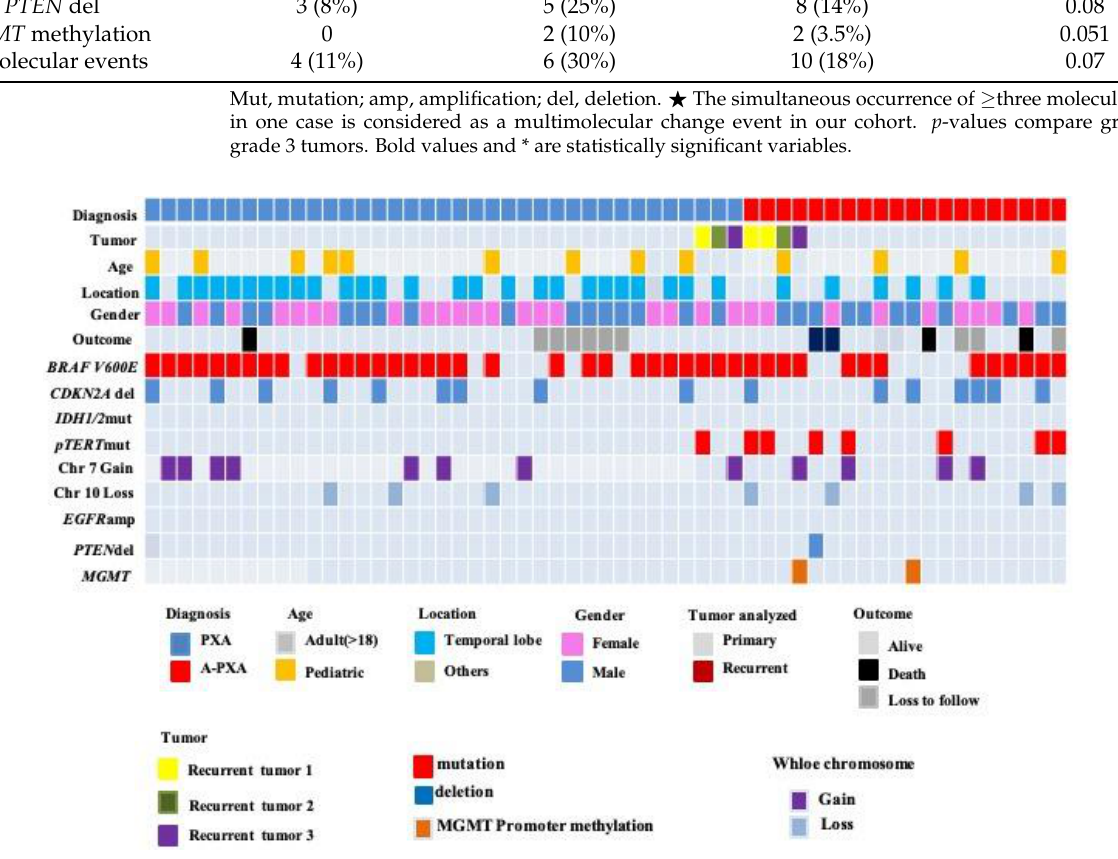
Figure 2. Clinical and molecular characteristics of the patient cohort. BRAF V600E mutations were identified by immunohistochemistry (IHC) or real-time polymerase chain reaction (PCR). MGMT promoter methylation status was assessed by methylation-specific real-time PCR system with an MGMT methylation analysis kit. TERT promoter mutations were identified by Sanger sequencing, and all of the mutation sites were C228T. CDKN2A/B , EGFR , and PTEN statuses were identified via fluorescence in situ hybridization (FISH).